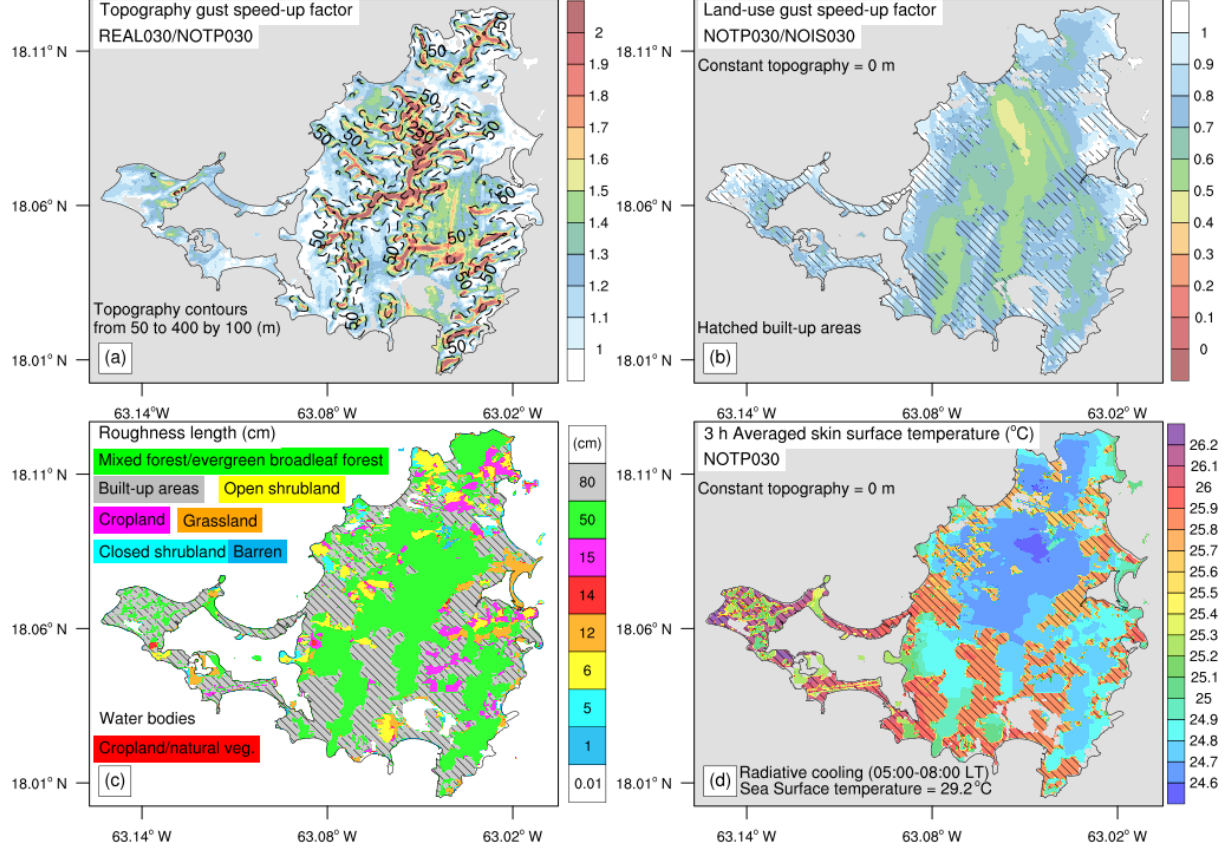
Figure 12. Effects of Saint Martin island terrain on maximum instantaneous gust. (a) Topography gust speed-up factor. (b) Land-use gust speed-up factor. (c) Surface roughness length ( cm ) . (d) 3h averaged skin surface temperature during the landfall in ◦ C: non-topography experiment, NOTP030. Table 2. Comparison of gusts, damage and socio-economic factors between Saint Martin (French entity, FR) and Saint Barthélemy over 100m grid cells, including an initial stock of at least 10